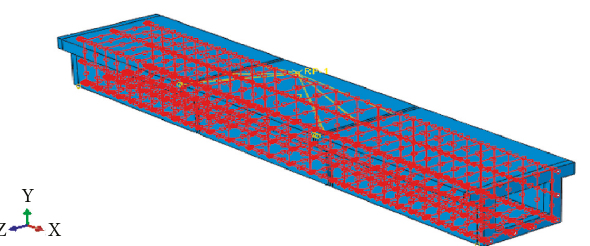
Figure 7: Interaction diagram.